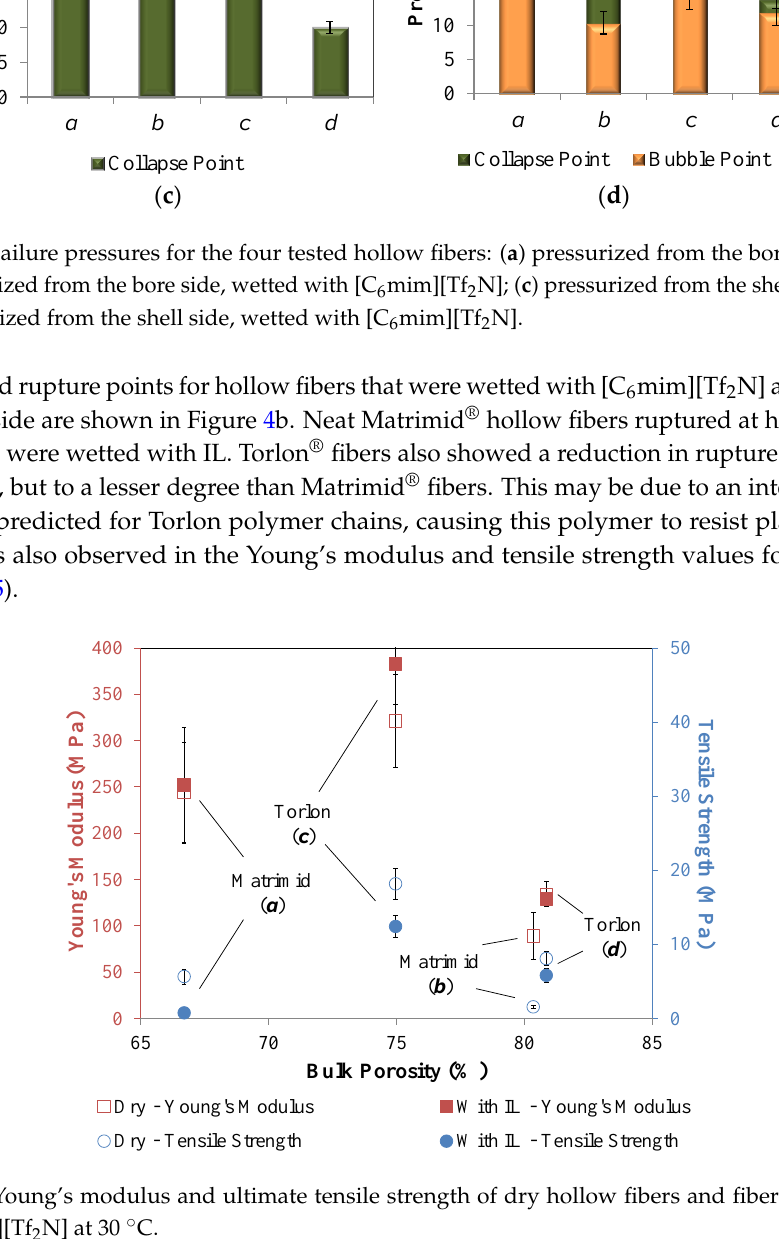
Figure 4. Failure pressures for the four tested hollow fibers: ( a ) pressurized from the bore side, dry; ( b ) pressurized from the bore side, wetted with [C 6 mim][Tf 2 N]; ( c ) pressurized from the shell side, dry; ( d ) pressurized from the shell side, wetted with [C 6 mim][Tf 2 N].